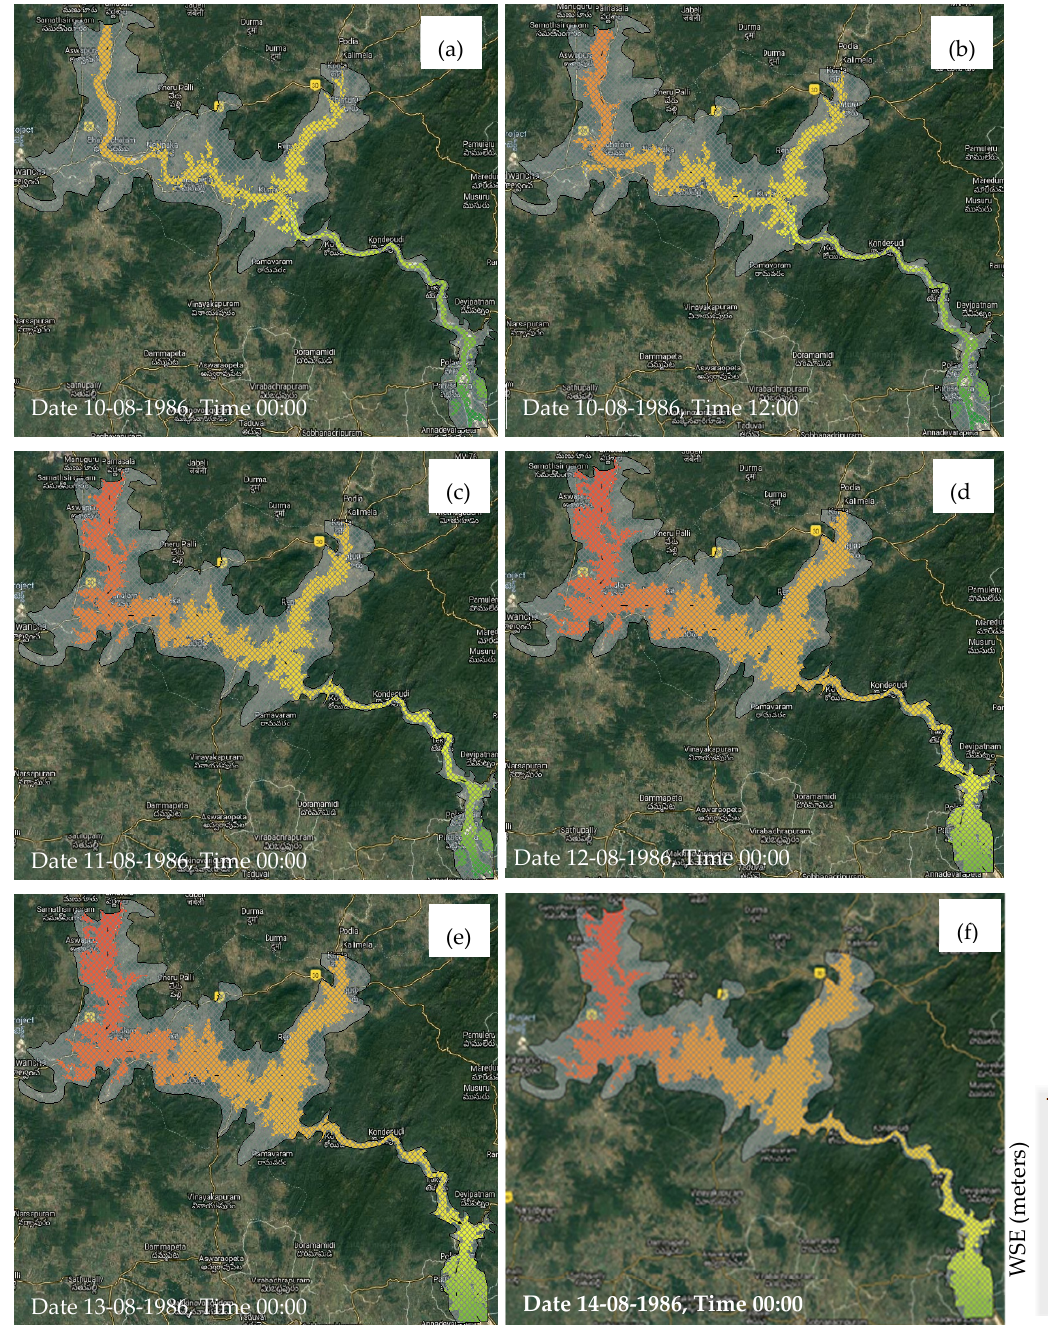
Figure 12. Simulated inundation map for a period of 10th –14th August 1986 without a dam. ( a ) and ( b ) shows inundation on 10th August 1986 at gap of 12 h. ( c ), ( d ), ( e ) and ( f ) shows inundation from 11th to 14th August at 00:00 h.